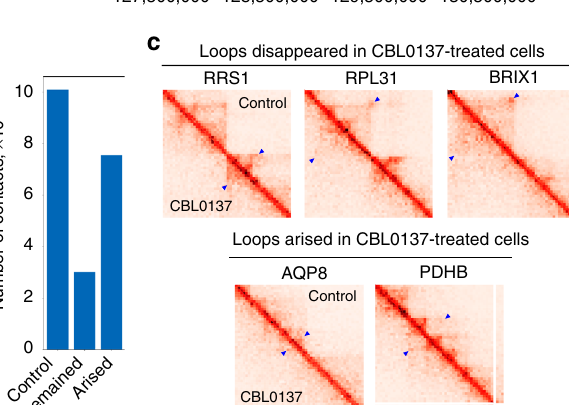
the mechanisms underlying the effects of CBL0137 on chromatin structure, we examined whether CBL0137 affected these archi- tectural factors. Treatment of HT1080 cells with CBL0137 for 6 h did not alter the protein levels of CTCF or the subunits of cohesin and condensin complexes (Rad21 and SMC2, respectively) (Fig. 6a). However, CBL0137 treatment of HT1080 cells led to a redistribution of CTCF, but not cohesin or condensin, from the fraction of proteins strongly associated with chromatin (Fig. 6b). This fi nding might re fl ect CTCF dissociation from its binding sites upon curaxin treatment. To test this assumption directly, we